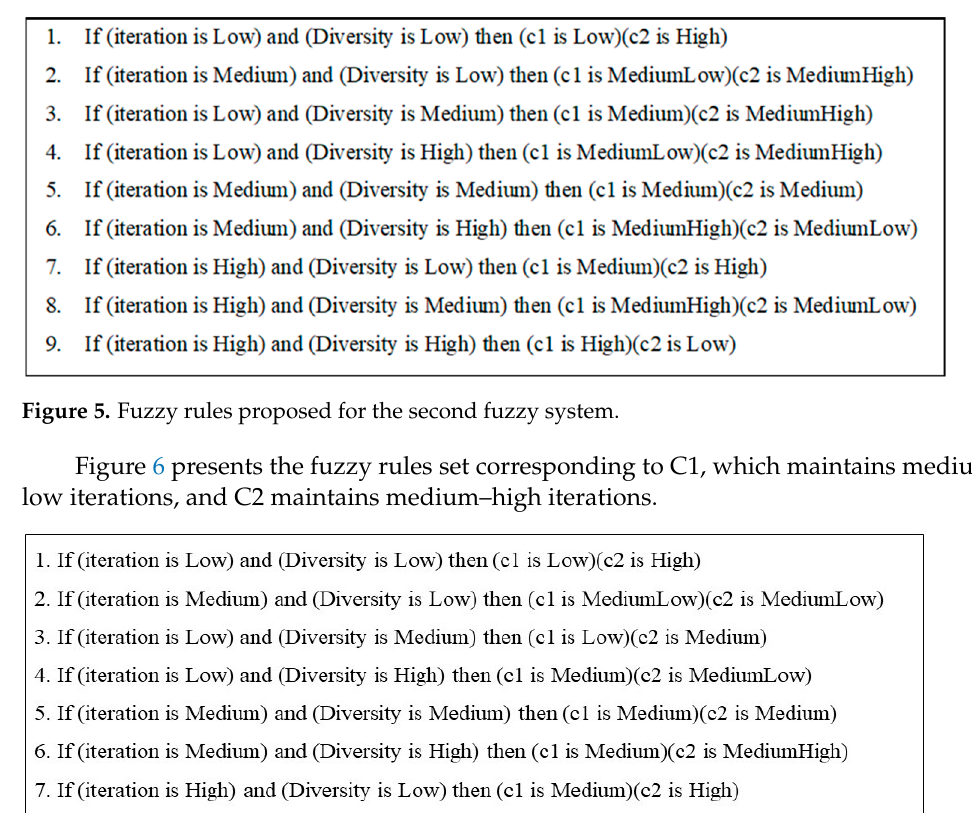
Figure 4. Fuzzy rules proposed for the first fuzzy system.